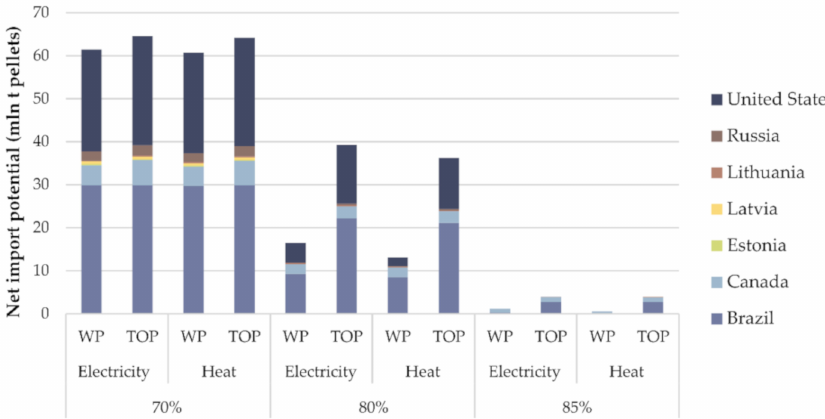
Figure 9. Techno-economic pellet production and net import potentials, CIF ARA, limited by supply chain GHG emissions–for wood pellets (WP) and torrefied pellets (TOP) produced from